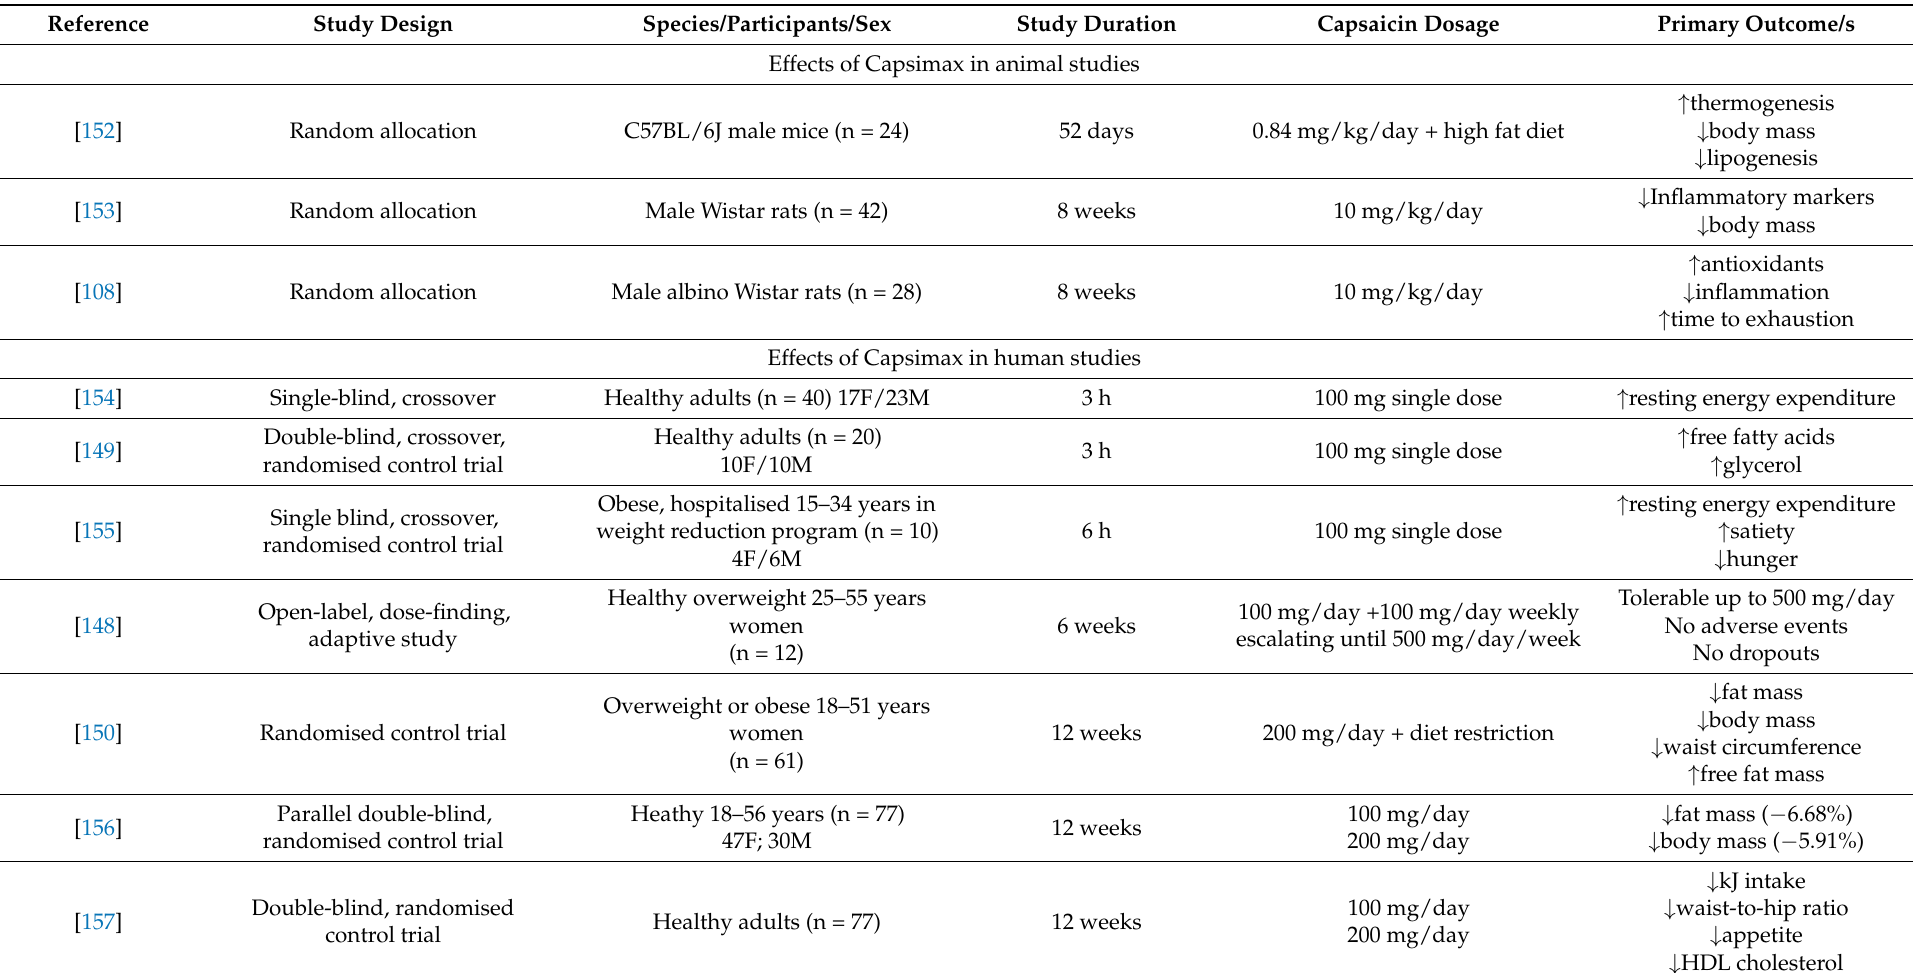
Table 3. Review of Capsimax intervention